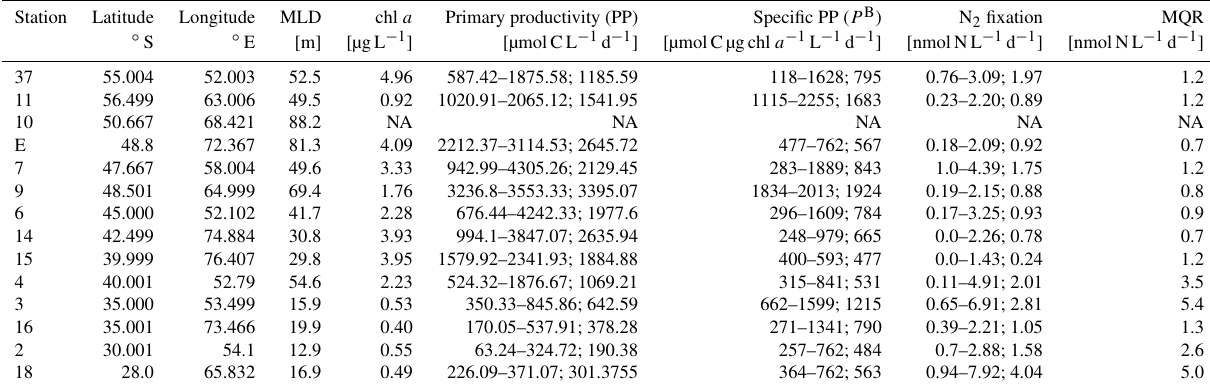
Table 1. Sampling stations visited during the MD206 cruise, including chlorophyll- a concentrations, primary productivity (PP), specific primary productivity ( P B ), and N 2 fixation. Mixed layer depth (MLD) was calculated using (cid:49)d = 0 . 03kgm − 3 compared to a surface reference depth of 7m. NA indicates no data. Ranges and mean for sample replicates of N 2 fixation and PP are given ( n = 3 for stations 3, 9, 11, 15; n = 6 for stations E, 37, 2, 4, 6, 7, 14, 16, 18). Station Latitude Longitude MLD chl a Primary productivity (PP) Specific PP ( P B ) N 2 fixation MQR ◦